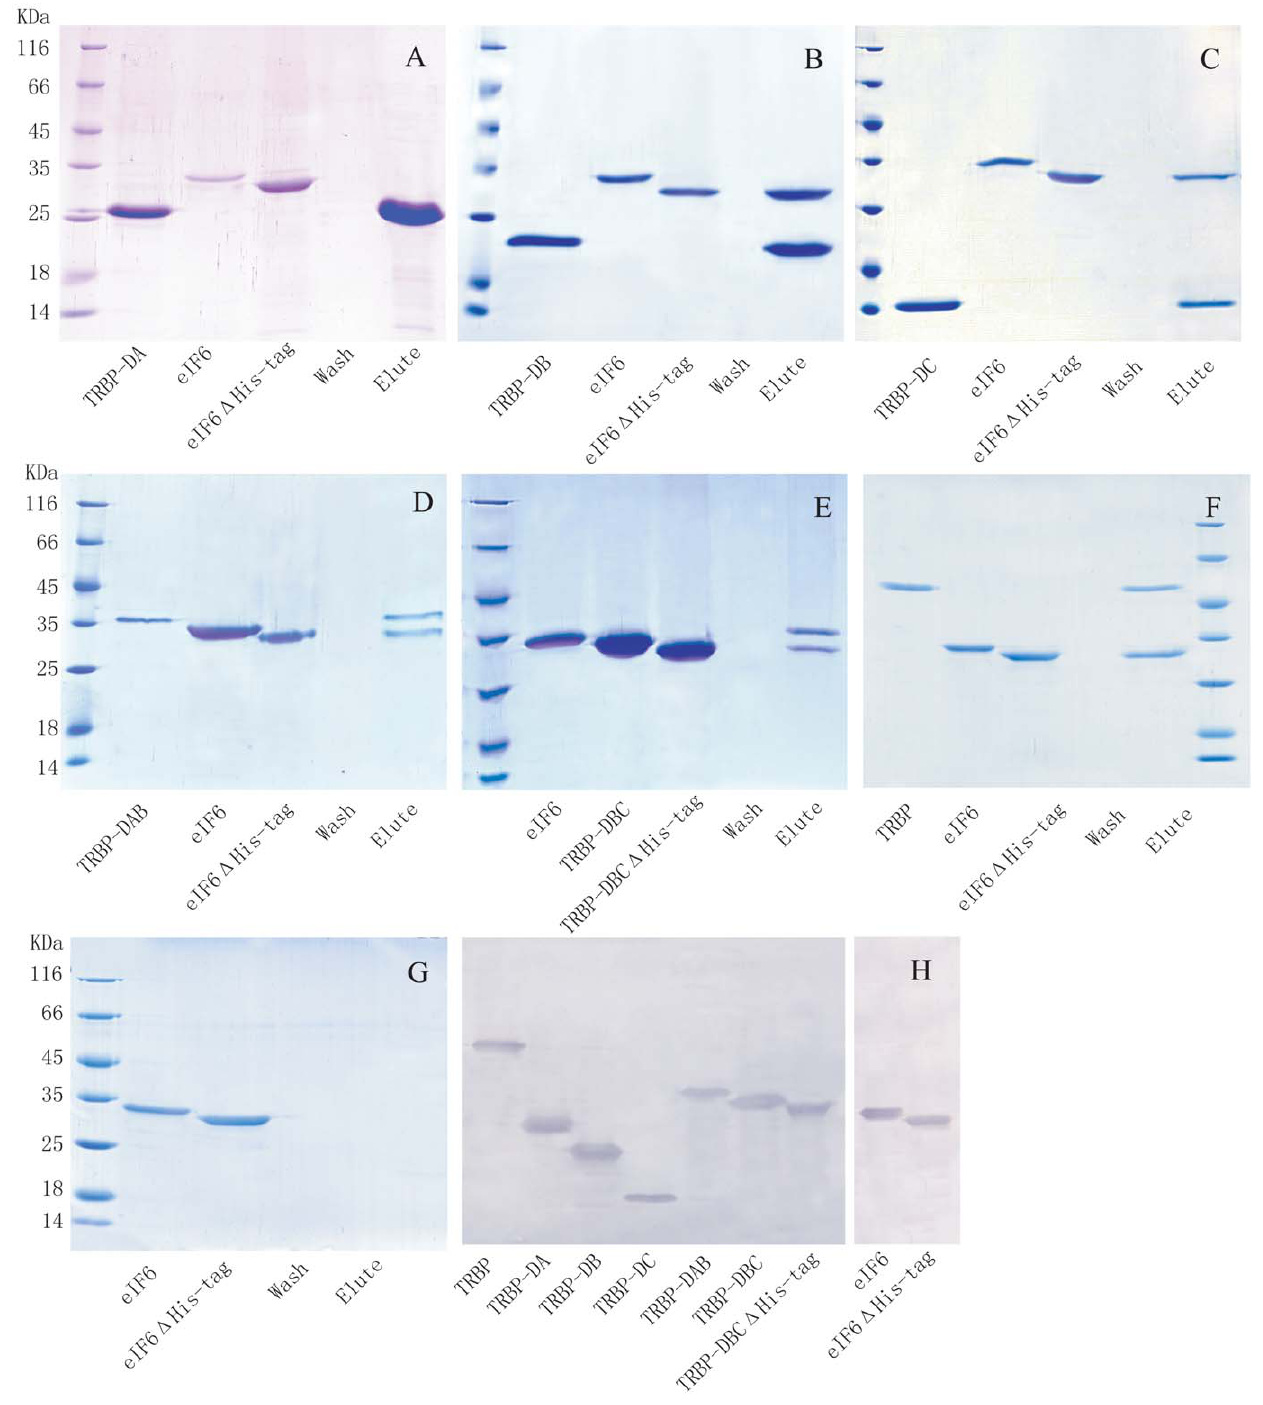
Figure 2. Pull-down assays that identify interactions between dsRBDs of Mj -TRBP and Fc -eIF6. A: Recombinant His-tagged TRBP-DA was incubated with His-Bind resin, to which eIF6 D His-tag (the His tag was removed from recombinant eIF6 by thrombin treatment and SDS-PAEG show the different mobility of eIF6 and eIF6 D His-tag, ensuring the His-tag of eIF6 D His-tag was removed completely) was added and incubated for 10 min. Wash buffer did not elute either protein, and elution buffer only eluted TRBP-DA, indicating the incapability of TRBP-DA to bind eIF6. B, C, D, E and F: The interactions between eIF6 and TRBP-DB, eIF6 and TRBP-DC, eIF6 and TRBP-DAB, eIF6 and TRBP-DBC eIF6 and full length TRBP (positive control) were identified by Pull down assays, respectively. G: The eIF6 D His-tag was incubated with His-Bind resin, and no protein was eluted after wash. H: To verify those proteins, western blot analysis was performed using TRBP (left) or eIF6 (right) specific antibody. The results indicated that eIF6 could be co-eluted with those TRBP fragments containing the second and third dsRBD, which indicated that the TRBP-DB and -DC, but not TRBP-DA mediated the interaction between TRBP and eIF6.